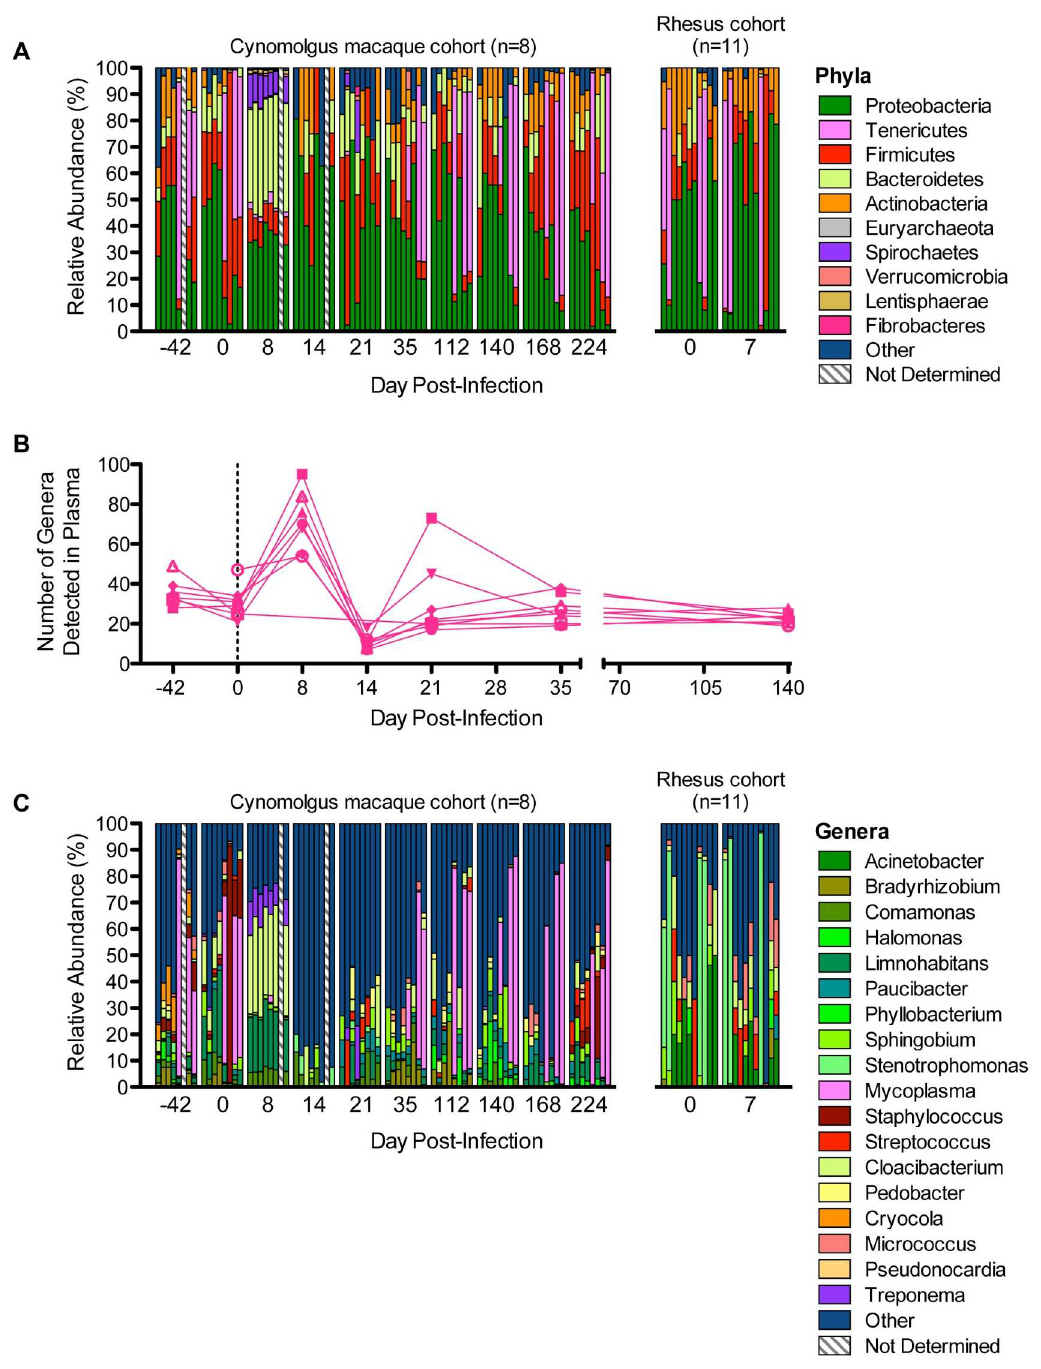
Fig 2. Taxonomic characterization of translocating microbial products. ( A ) Longitudinalrelative abundance (%) of major phyla detected in blood plasma. ( B ) Number of uniquebacterial generafor which genomicDNA was detected in blood plasma throughoutthe period of observation. Each line corresponds to a single animal.( C ) Longitudinal relative abundance (%) of major generadetected in blood plasma. For (A and C), vertical bars within a given cluster (time-point) correspond to each individual animal, and coloredsegments correspond to the proportionof specific taxa. Owing to sample limitations, relative abundance of microbialtaxa could not be determined for all animalsat all time-points.